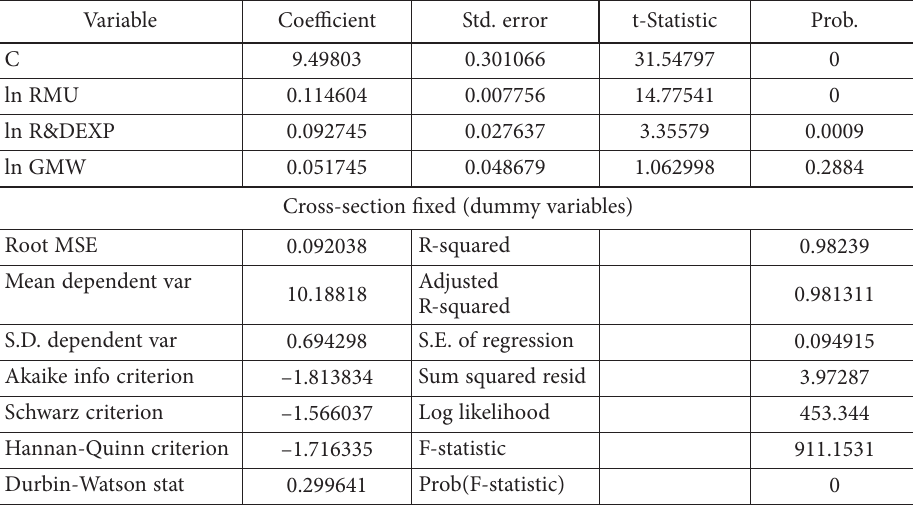
Table 9. Summary of FEM – determinants of GDP per